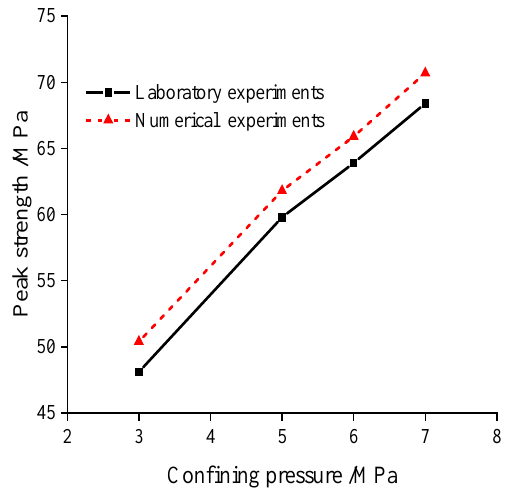
Figure 2. Numerical and experimental results under different confining pressures.